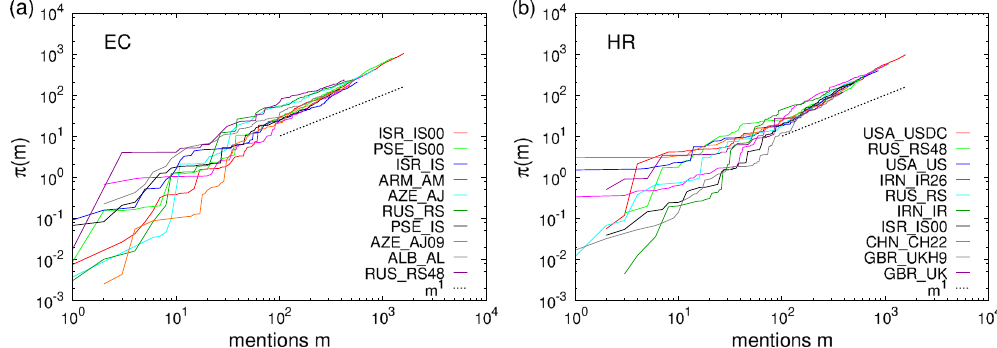
Figure 5. Cumulative growth rates π ( m ) for mentions m for ( a ) EC and ( b ) HR datasets. The curves asymptotically fit to π ∼ α m m ( ) with α > 1. The precise fitting exponents are given in Supplementary Table S4.